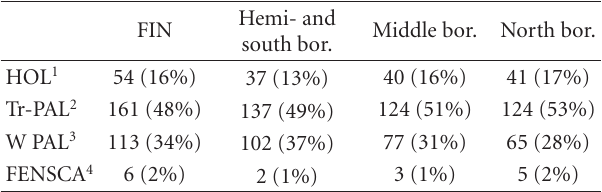
Geographic distance (km) Figure 4: Correlation between provincial crane fly (Diptera, Tipuloidea), assemblage dissimilarity (1-Jaccard coe ffi cient), and geographical distance (km) of the provinces. Table 4: Total numbers and proportions of di ff erent distribution types among crane flies (Diptera, Tipuloidea) in Finland and in the ecoregions (hemi and south boreal, middle boreal, and north